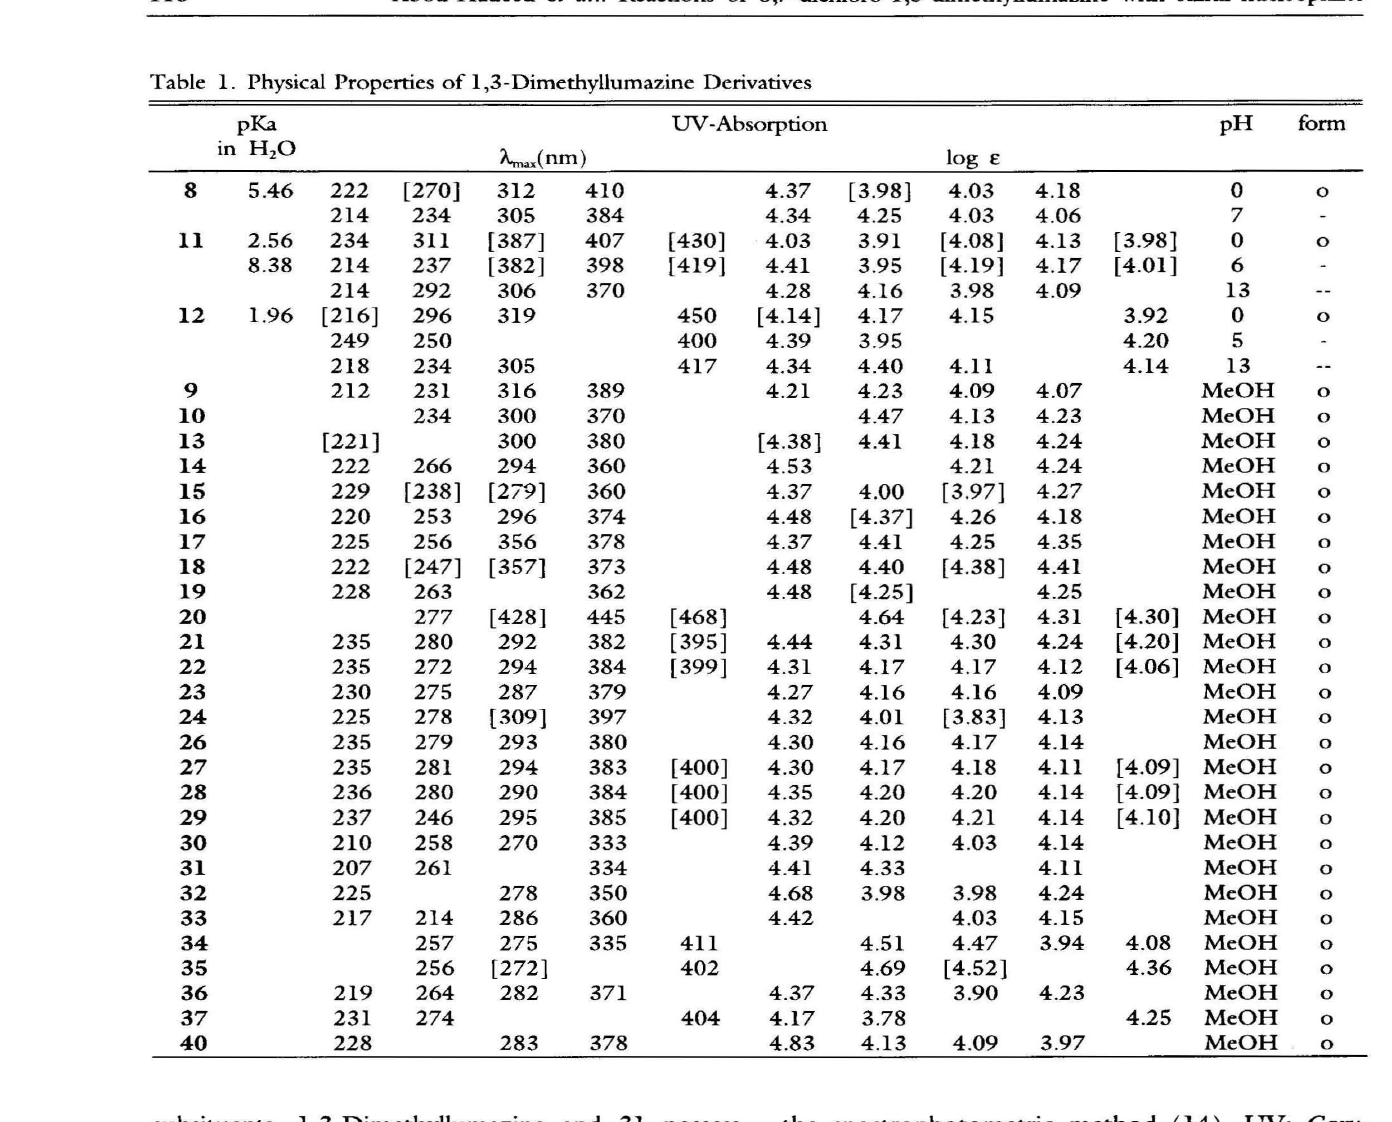
Table 1. Physical Properties of 1,3-Dimethyllumazine